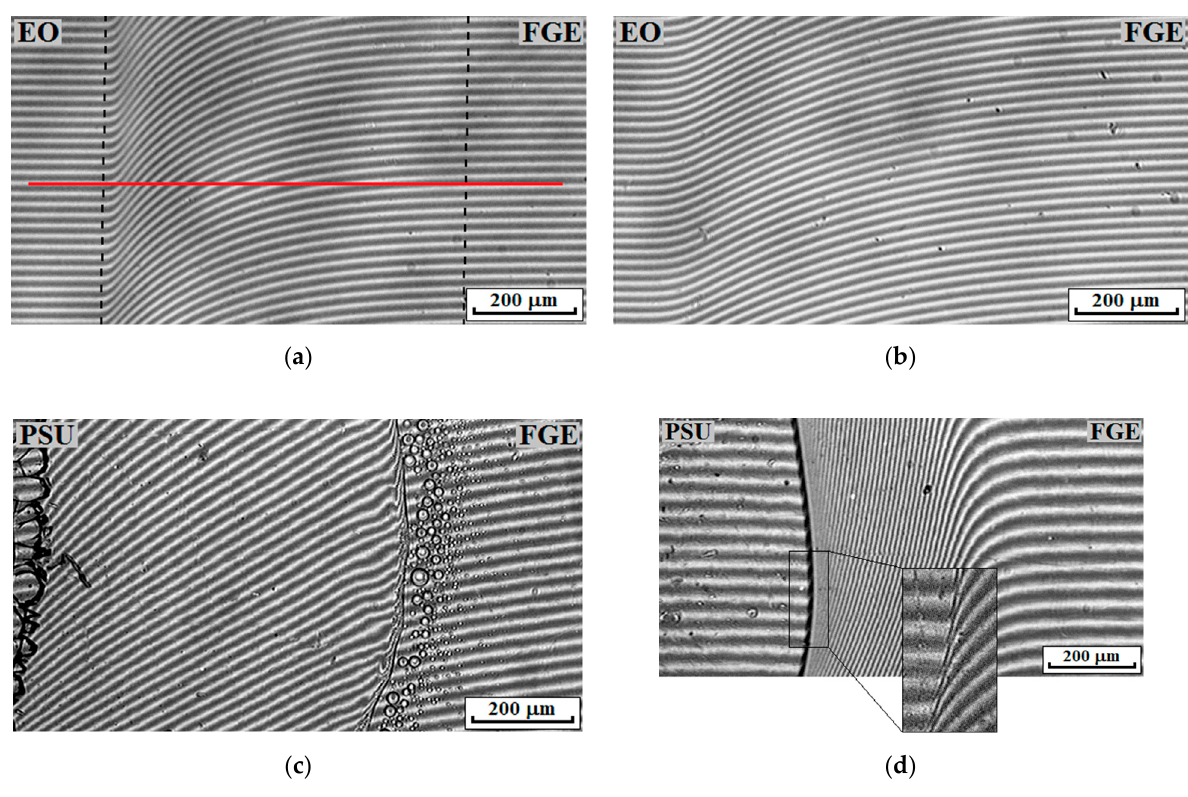
Figure 1. Interferograms of the interdiffusion zones of the EO–FGE ( a , b ) and PSU–FGE ( c , d ) systems at 20 ( a , c ) and 160 ◦ C ( b , d ).